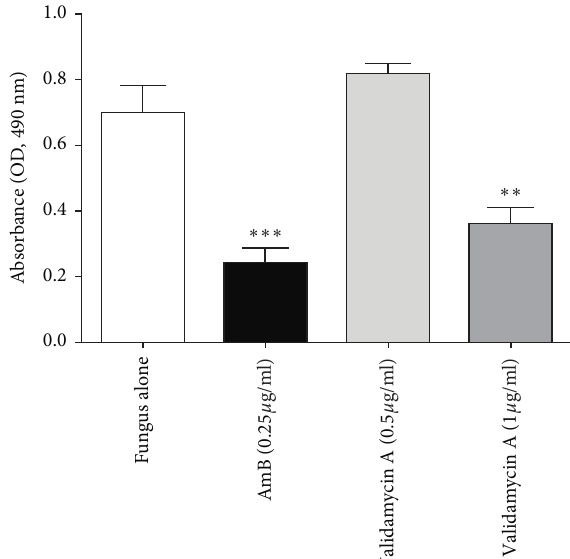
Figure 3: Validamycin A inhibits the growth of Aspergillus flavus . Aspergillus flavus ATCC204304 was cultured at 37 ° C in RPMI media in a 24-well plate for 18 hours. Fungal viability was measured by XTTassays at 490nm. Amp, amphotericin B at 0.25 μ g/mL. Data are presented as means ± SE from three biological replicates. ∗∗ P value < 0.01; ∗∗∗ P value < 0.001 (one-way ANOVA with post hoc Bonferroni’s test compared to fungus